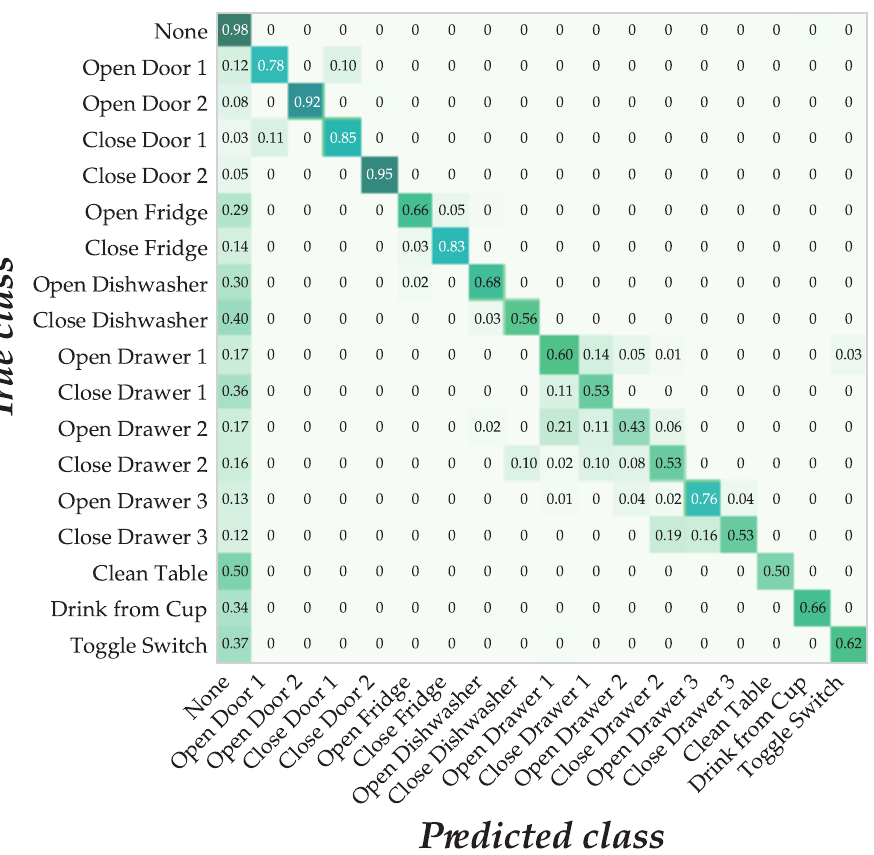
Figure 6. Evolution of the F1 scores of the incremental ensembles using the best 20 individuals from the GE with OPPORTUNITY Gestures.